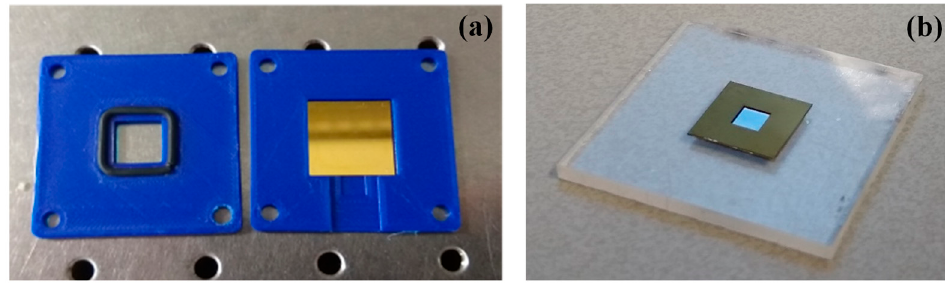
Figure 1. Silicon nitride membranes made by ( a ) Silison and ( b ) Norcada. Three different types of 3D-printed holders were used to keep the silicon nitride